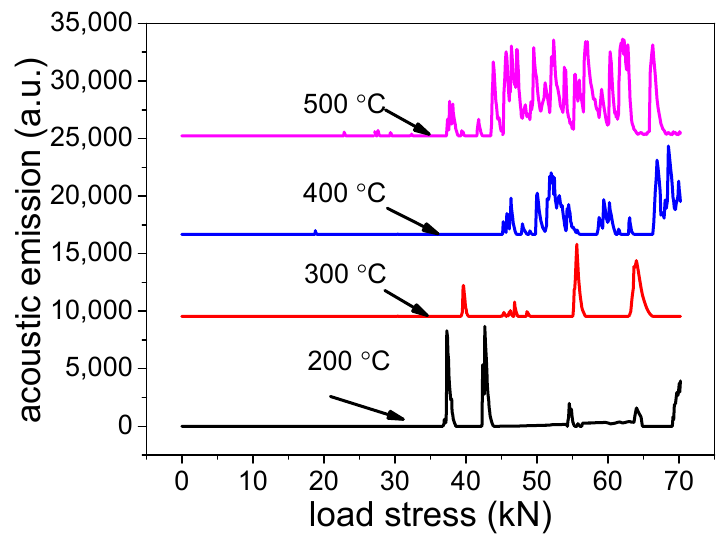
Figure 9. Adhesion between coatings and substrate.